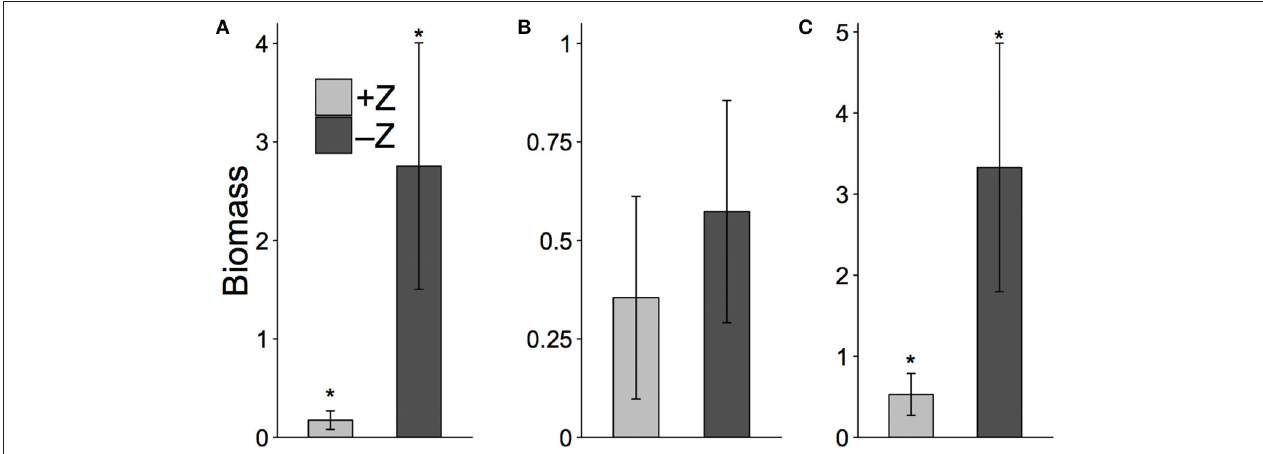
FIGURE 5 | Mean biomass concentration (mgC.L − 1 ) of Cryptomonas (A) , Microcystis (B), and total phytoplankton (C) in the treatments with copepods ( + Z) and no-grazer controls (–Z), at end of facilitation experiment (day 6). Error bars show 95% confidence intervals. *Represents a significant difference (i.e., p < 0.05) between control and